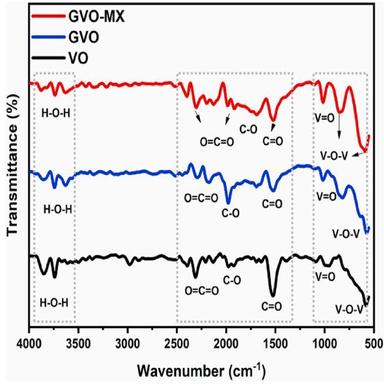
FT-IR spectra showing different vibrational modes in VO, GVO and GVO/MX.